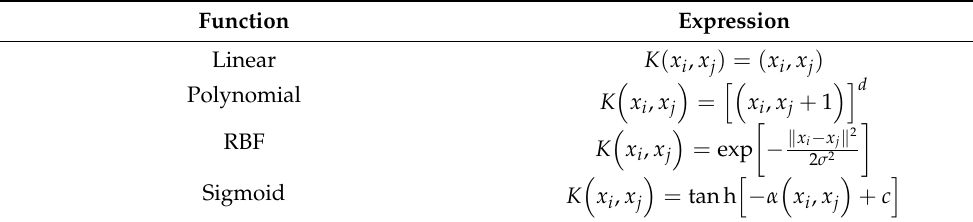
Table 2. Different kernel functions